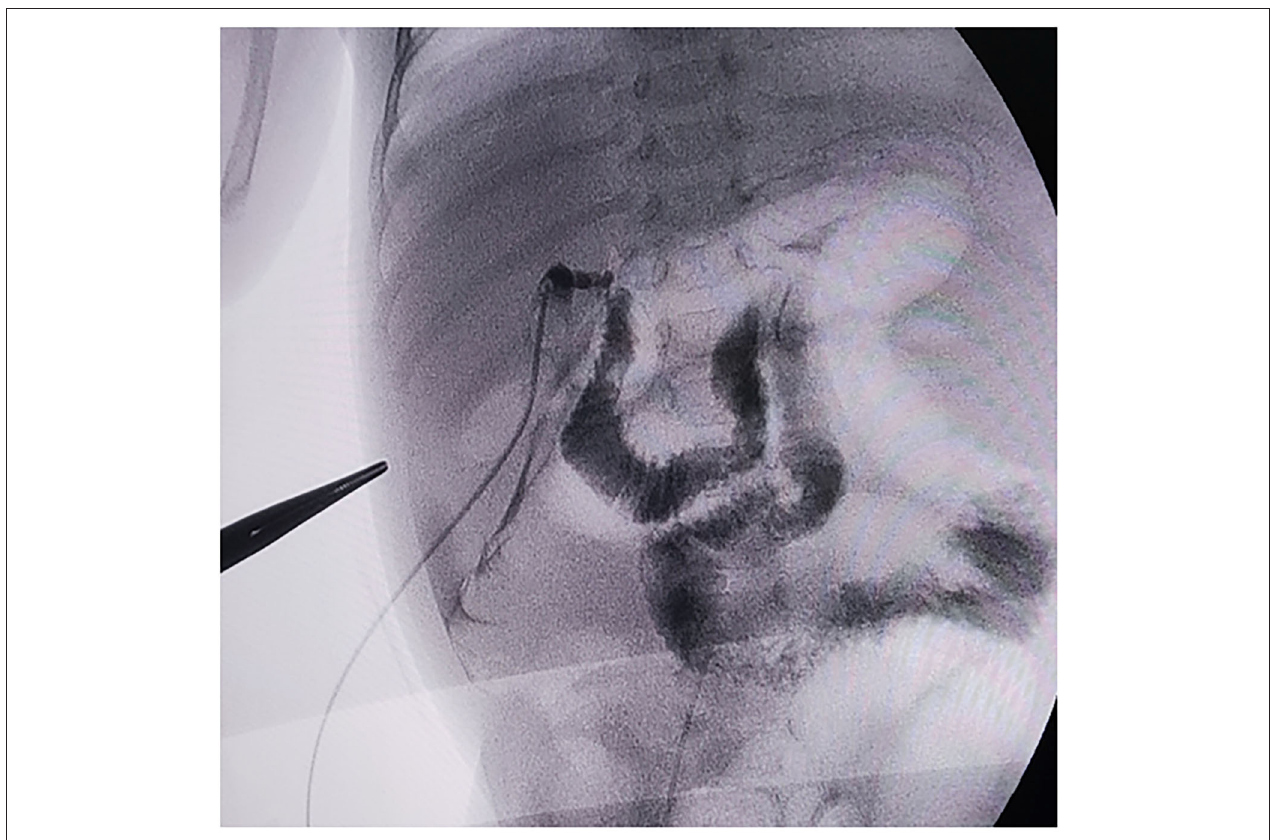
FIGURE 3 | X-ray of the cholangiography during the second